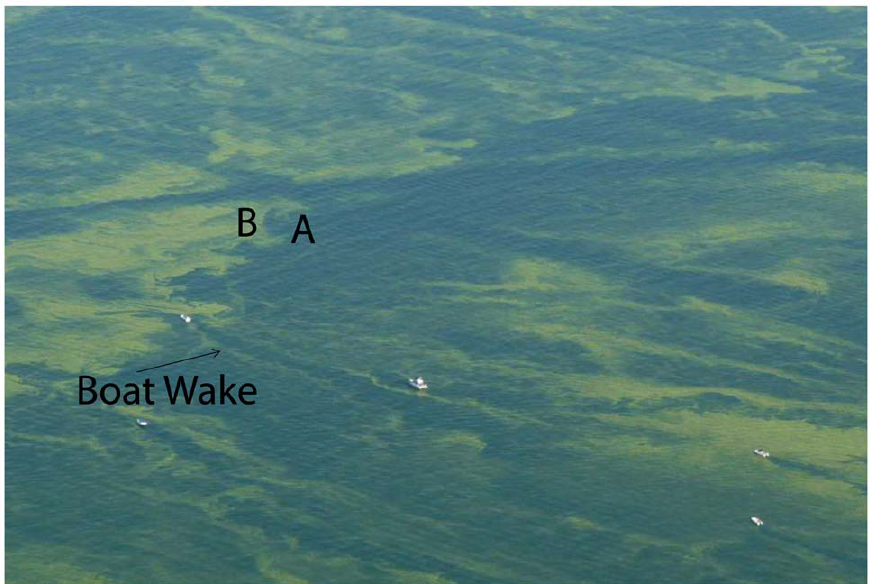
Figure 4. Aerial photograph of Microcystis bloom in western Lake Erie, early in the 2009 bloom, showing the spatial variability during intense blooms. ‘‘A’’ shows less dense and mixed bloom, ‘‘B’’ shows denser bloom aggregating at the water surface. Mixing can be seeing within the boat wake. Image width is approximately 400 m (credit Tom Archer).